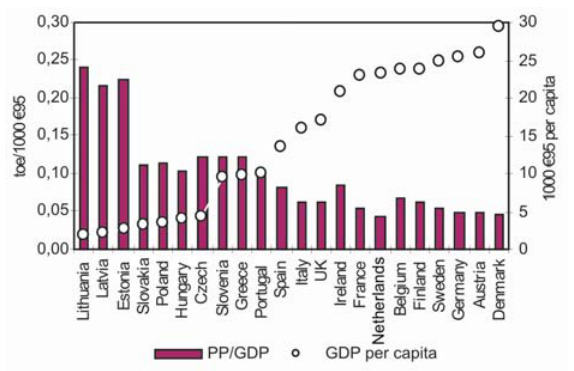
Fig 5. Changes of expenditure intensity of petroleum products (PP/GDP) and GDP per capita in EU countries